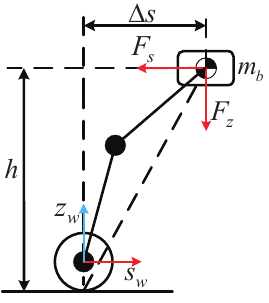
Figure 3. Stability analysis of the lumped mass model. ∆ s is the horizontal offset of the CoM relative to the wheel. h is the vertical height of the CoM, which can be calculated from the leg kinematics. F s and F z represent horizontal inertial force and vertical inertia force,